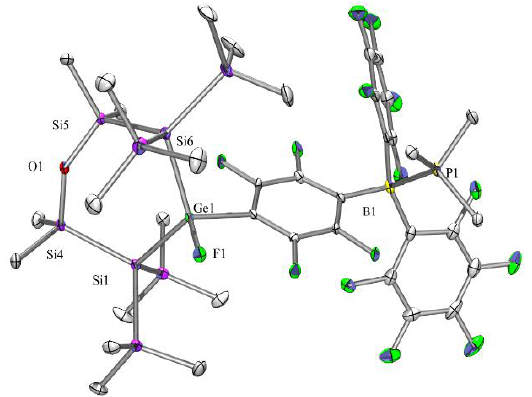
Figure 6. Molecular structure of compound 10 (thermal ellipsoid plot drawn at the 30% probability level). All hydrogen atoms are omitted for clarity (bond lengths in Å, angles in deg). Ge(1)-F(1)